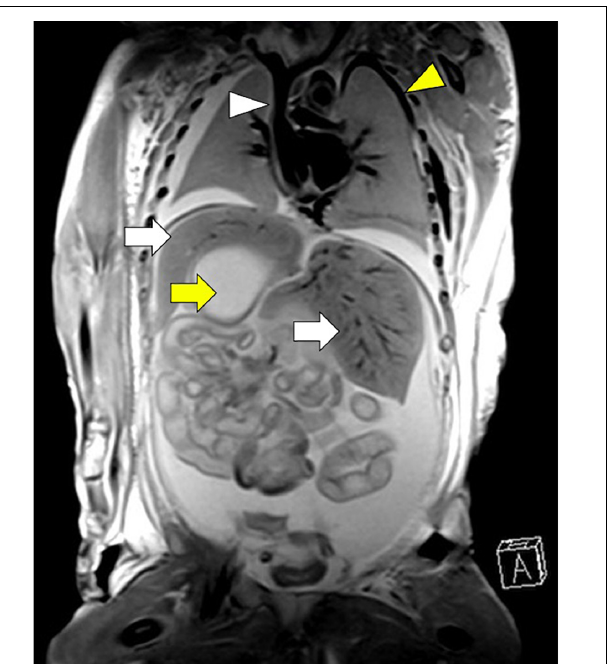
FIGURE 5 | Concordant pattern of broncho-pulmonary branching confirmed by post-mortem MRI in the left atrial isomerism cohort. Arrows: white, bilateral liver; yellow, right-sided stomach. Arrowheads: white, right atrium with insertion of vena cava superior, but without vena cava inferior, yellow, vena azygos supplying blood of the lower body half. Gestational age at MRI is 23 weeks + 4